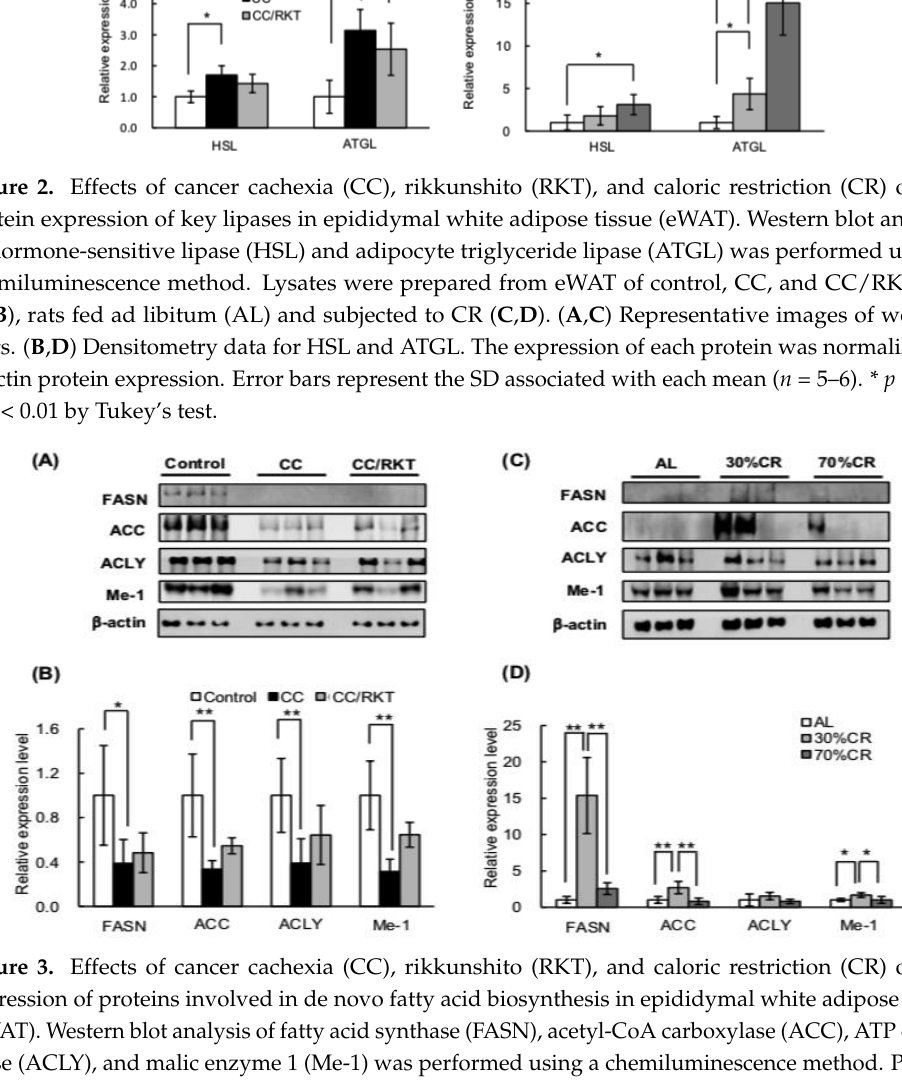
Figure 3. Effects of cancer cachexia (CC), rikkunshito (RKT), and caloric restriction (CR) on the expression of proteins involved in de novo fatty acid biosynthesis in epididymal white adipose tissue (eWAT). Western blot analysis of fatty acid synthase (FASN), acetyl-CoA carboxylase (ACC), ATP citrate lyase (ACLY), and malic enzyme 1 (Me-1) was performed using a chemiluminescence method. Protein samples were extracted from eWAT of ( A , B ) control, CC, and CC/RKT rats, and ( C , D ) rats fed ad libitum (AL) and subjected to CR. ( A , C ) Representative images of western blots. ( B , D ) Densitometry data for FASN, ACC, ACLY, and Me-1. Protein levels were normalized to β -actin protein expression. Error bars represent the SD associated with each mean ( n = 5–6). * p < 0.05, ** p < 0.01 by Tukey’s test.